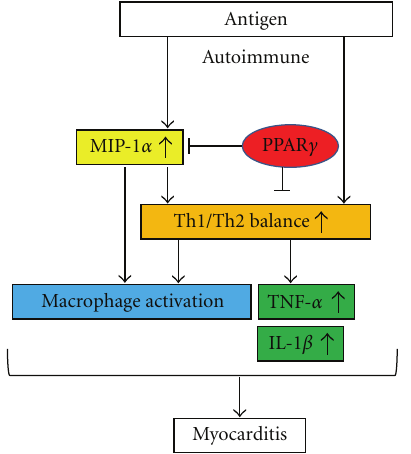
Figure 3: Inhibitory mechanisms of PPAR γ on autoimmune induced myocarditis. PPAR γ inhibits the progression of autoim- mune induced myocarditis via inhibition of the activation of Th1/Th2 balance, MIP-1 α , proinflammatory cytokines TNF- α /IL- 1 β , and